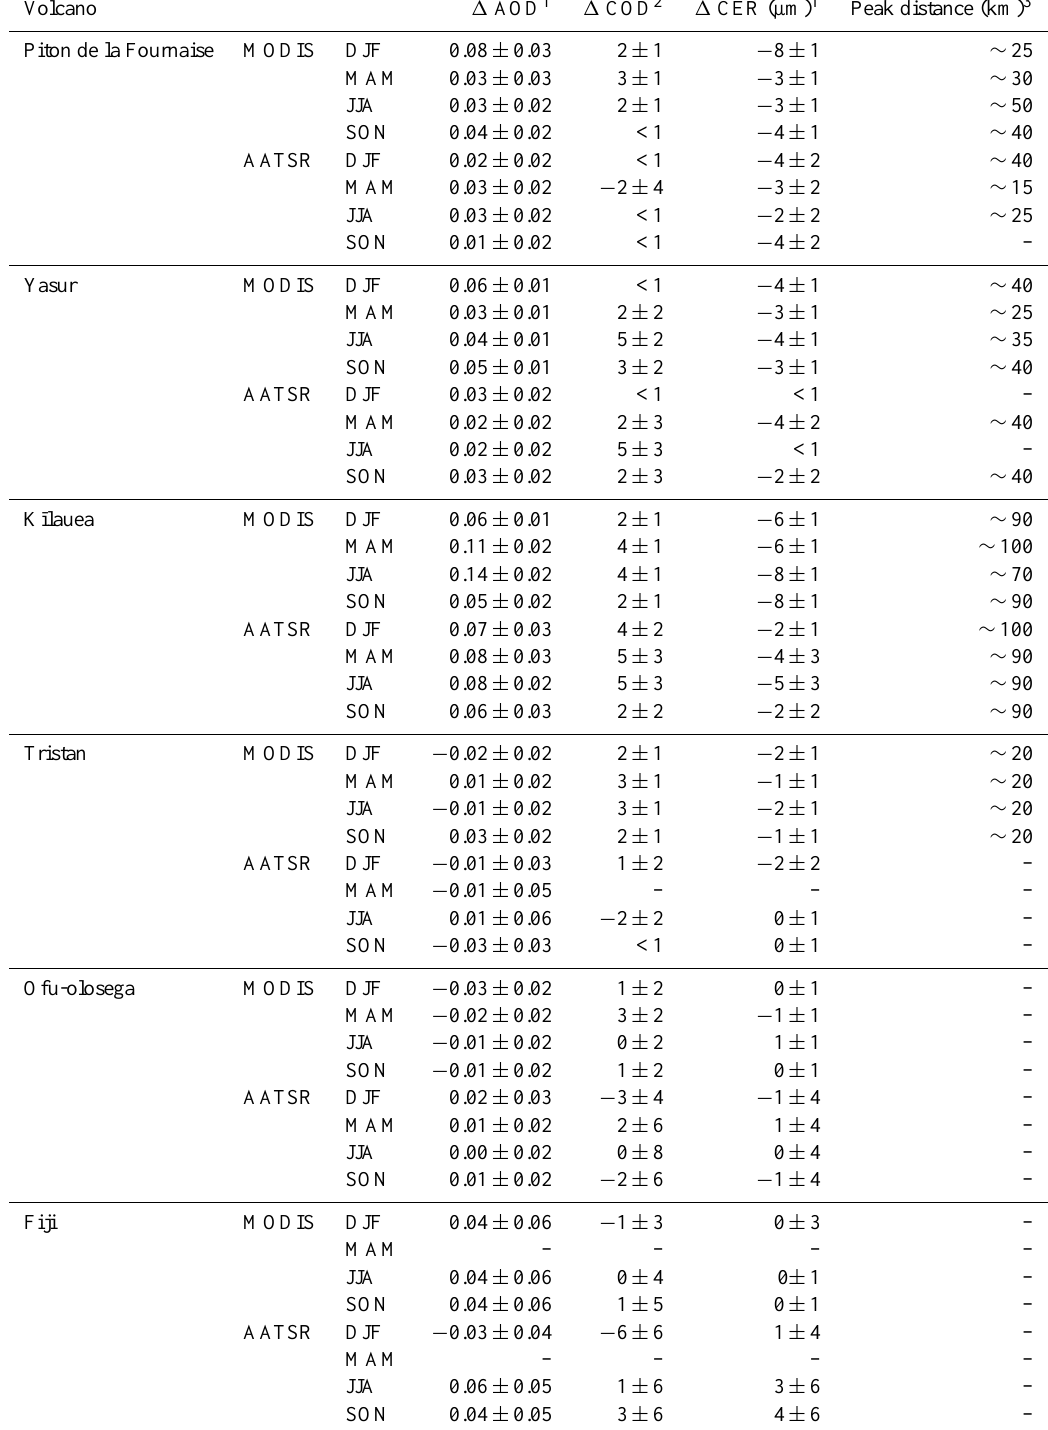
Table 2. Average difference in upwind and downwind cloud and aerosol properties for MODIS (Aqua) and AATSR retrievals for volcanoes discussed in this study. Uncertainties are the square root of the sum of squares of the standard errors of upwind and downwind values. Volcano Piton de la